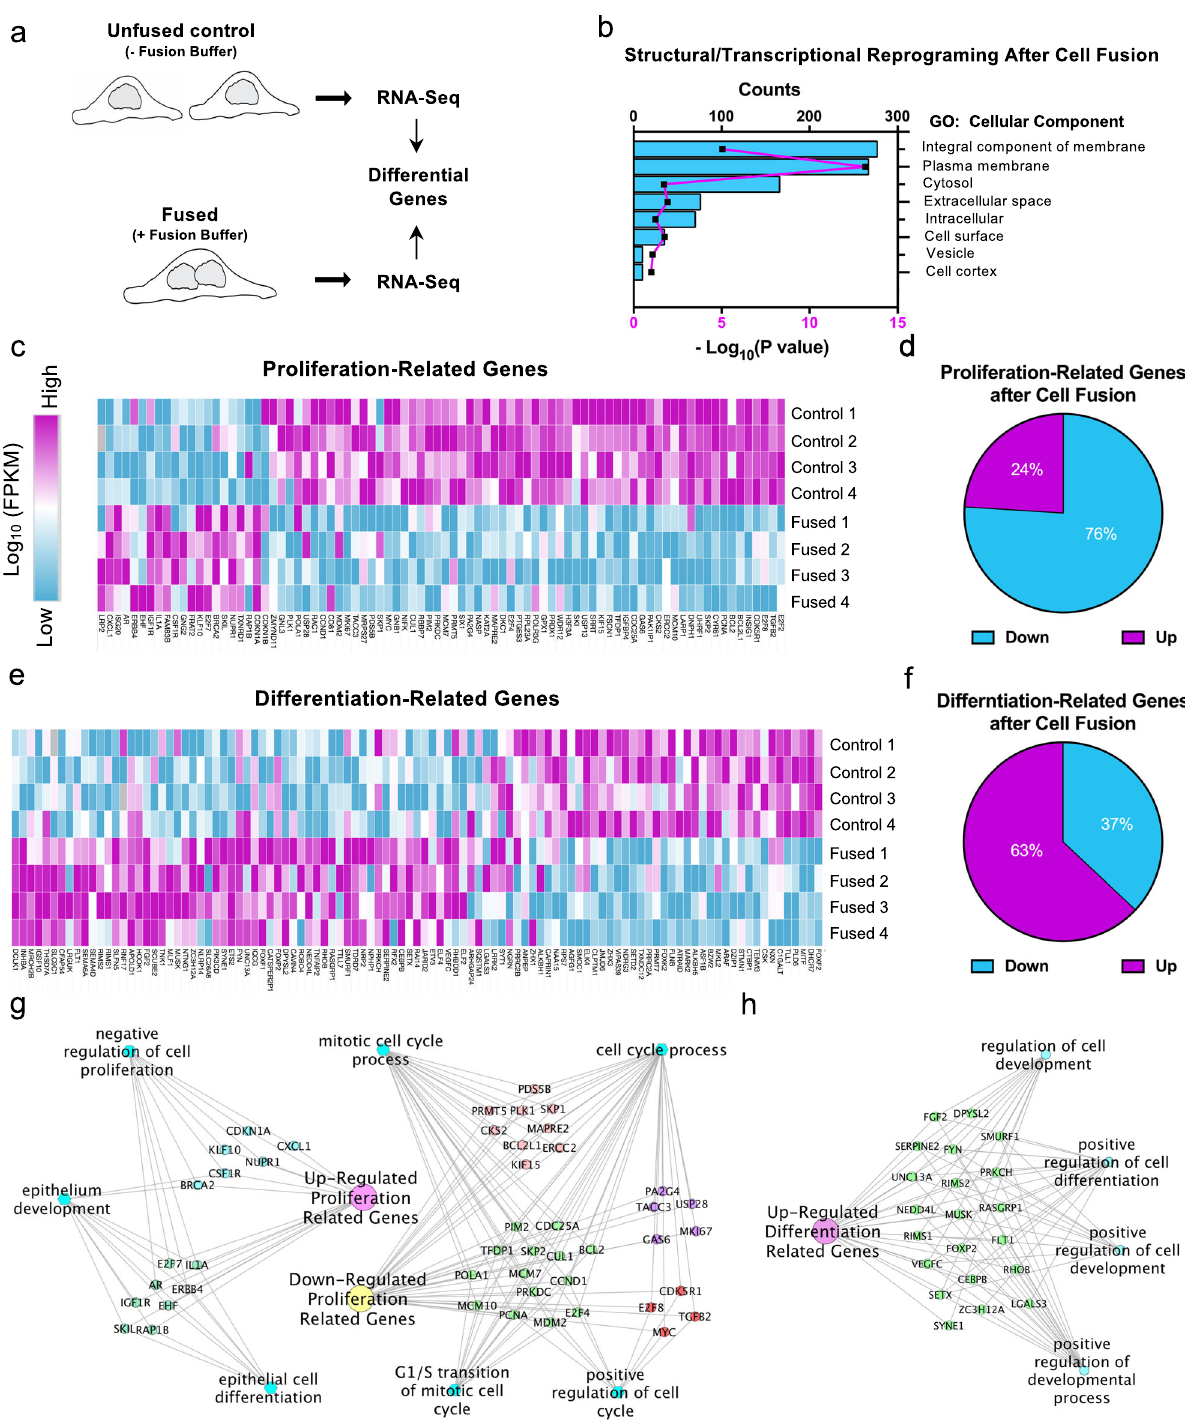
Fig. 2 Cell fusion decreases the expression of proliferation-related genes while promoting expression of genes involved in differentiation and cell- cycle arrest. a Graphical description of RNA-Seq work fl ow to compare cell transcriptional pro fi les of unwashed control cells to fused SUM-159 cells 6 h after induction of cell fusion. b Genes differentially expressed between fused and control cells were fi ltered by gene ontologies (GO). The differentially expressed genes were grouped into cellular component genes that signi fi cantly changed after cell fusion. c – f Differentially expressed genes were fi ltered to identify cell proliferation-related (GO 0008283) and cell differentiation-related (GO 0030154) transcripts. c , e Expression levels (Log10 FPKM) of four independent experiments are shown as heatmap visualizations of the percentage of proliferation ( d ) and differentiation ( f ) genes that were down or upregulated after cell fusion. g , h ToppCluster plots showing the functional network among differentiation and proliferation-related differentially expressed